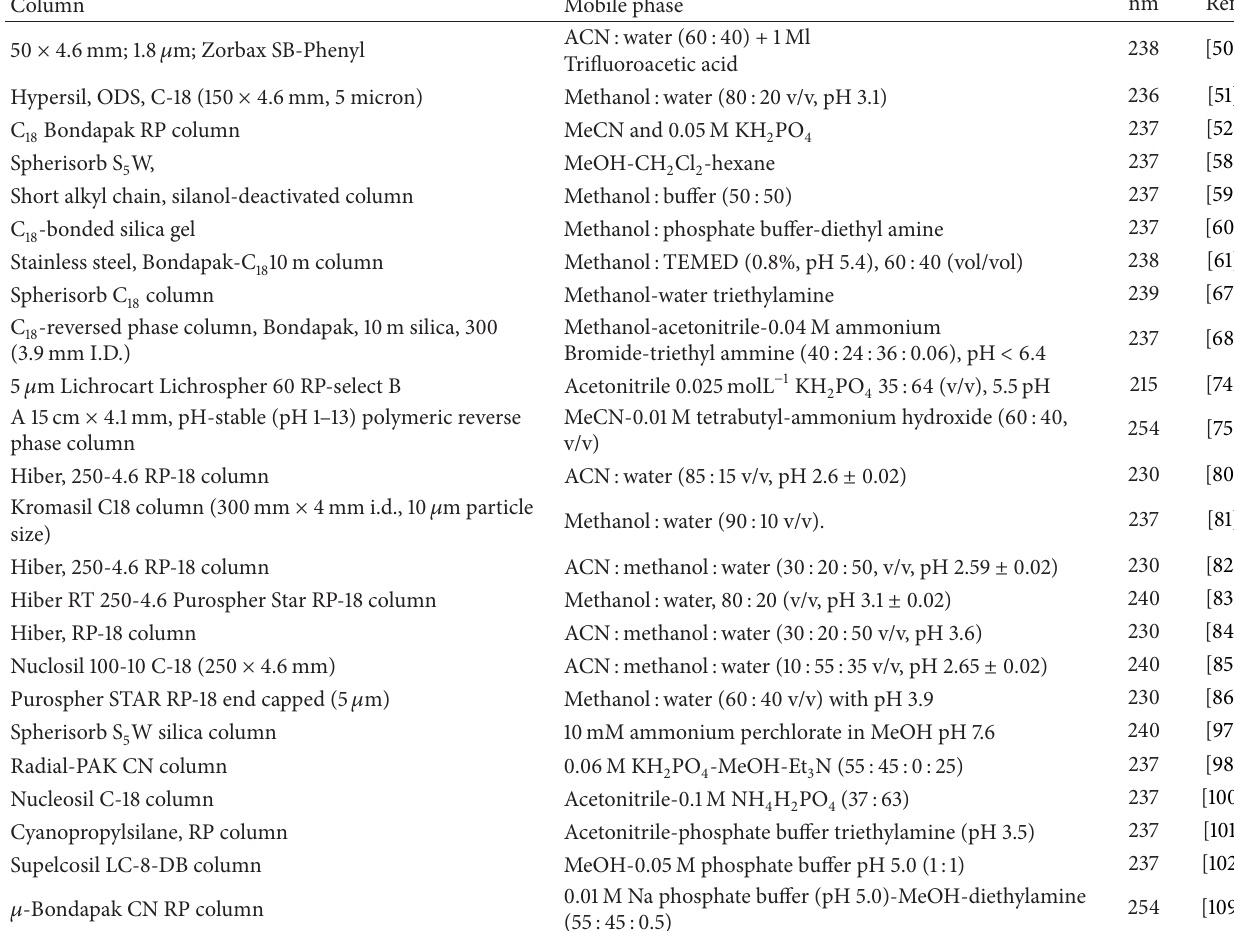
Table 2: Application of HPLC to the determination of